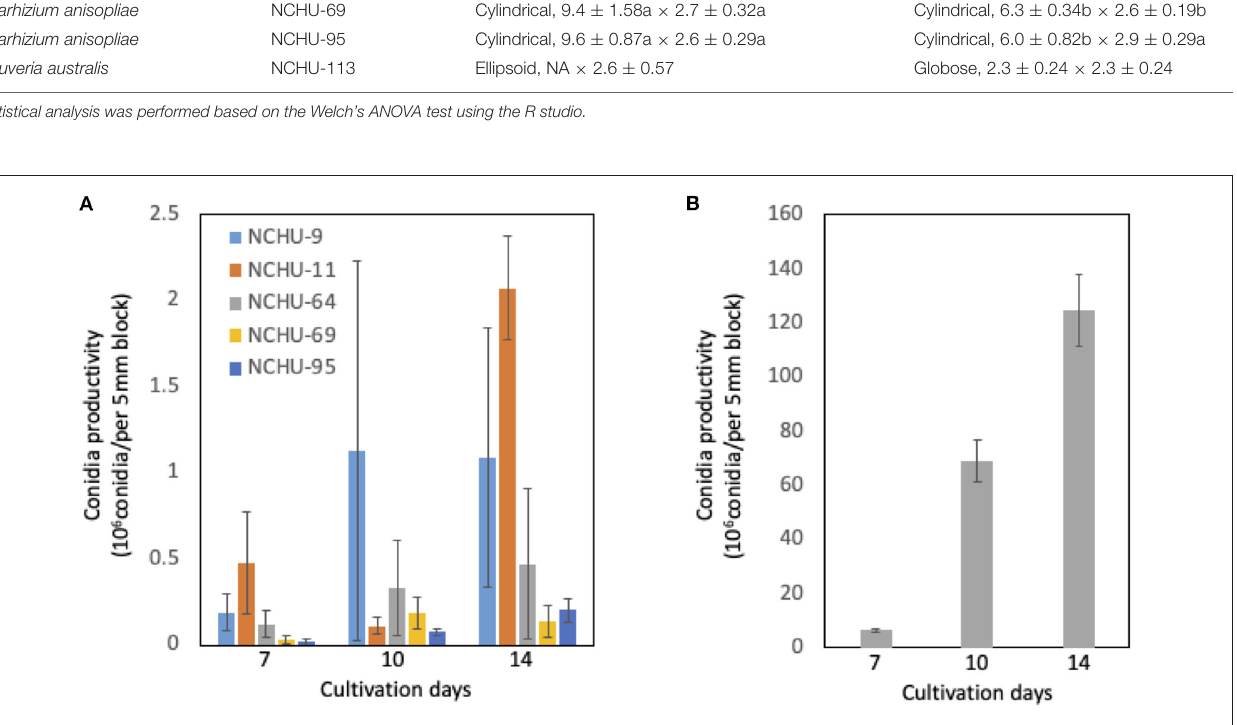
FIGURE 6 | (A–B) Conidial production of six fungal isolates. The conidial production data were collected after 7, 10, and 14 d of culture. The conidia of three blocks (5mm in diameter) were calculated for each fungal isolate. The experiments were replicated three times for each fungal isolate.